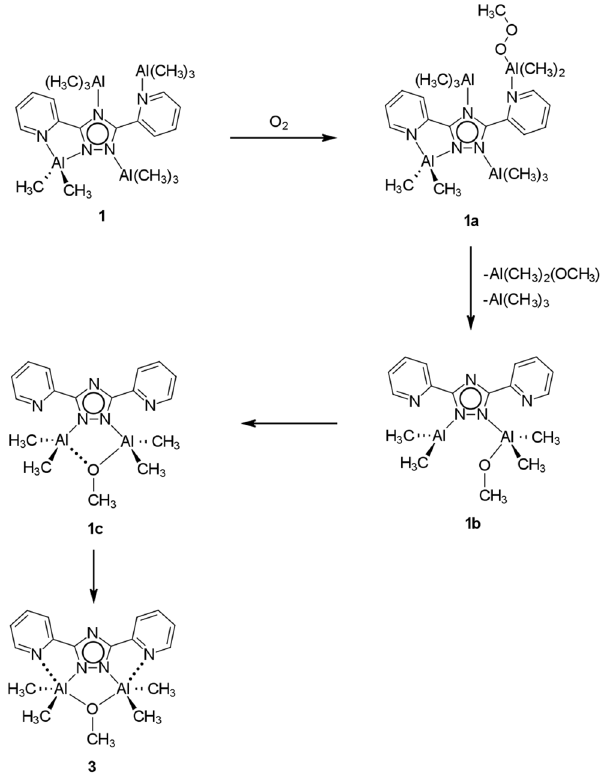
Figure 6. Proposed mechanism for the insertion of O 2 into 1.